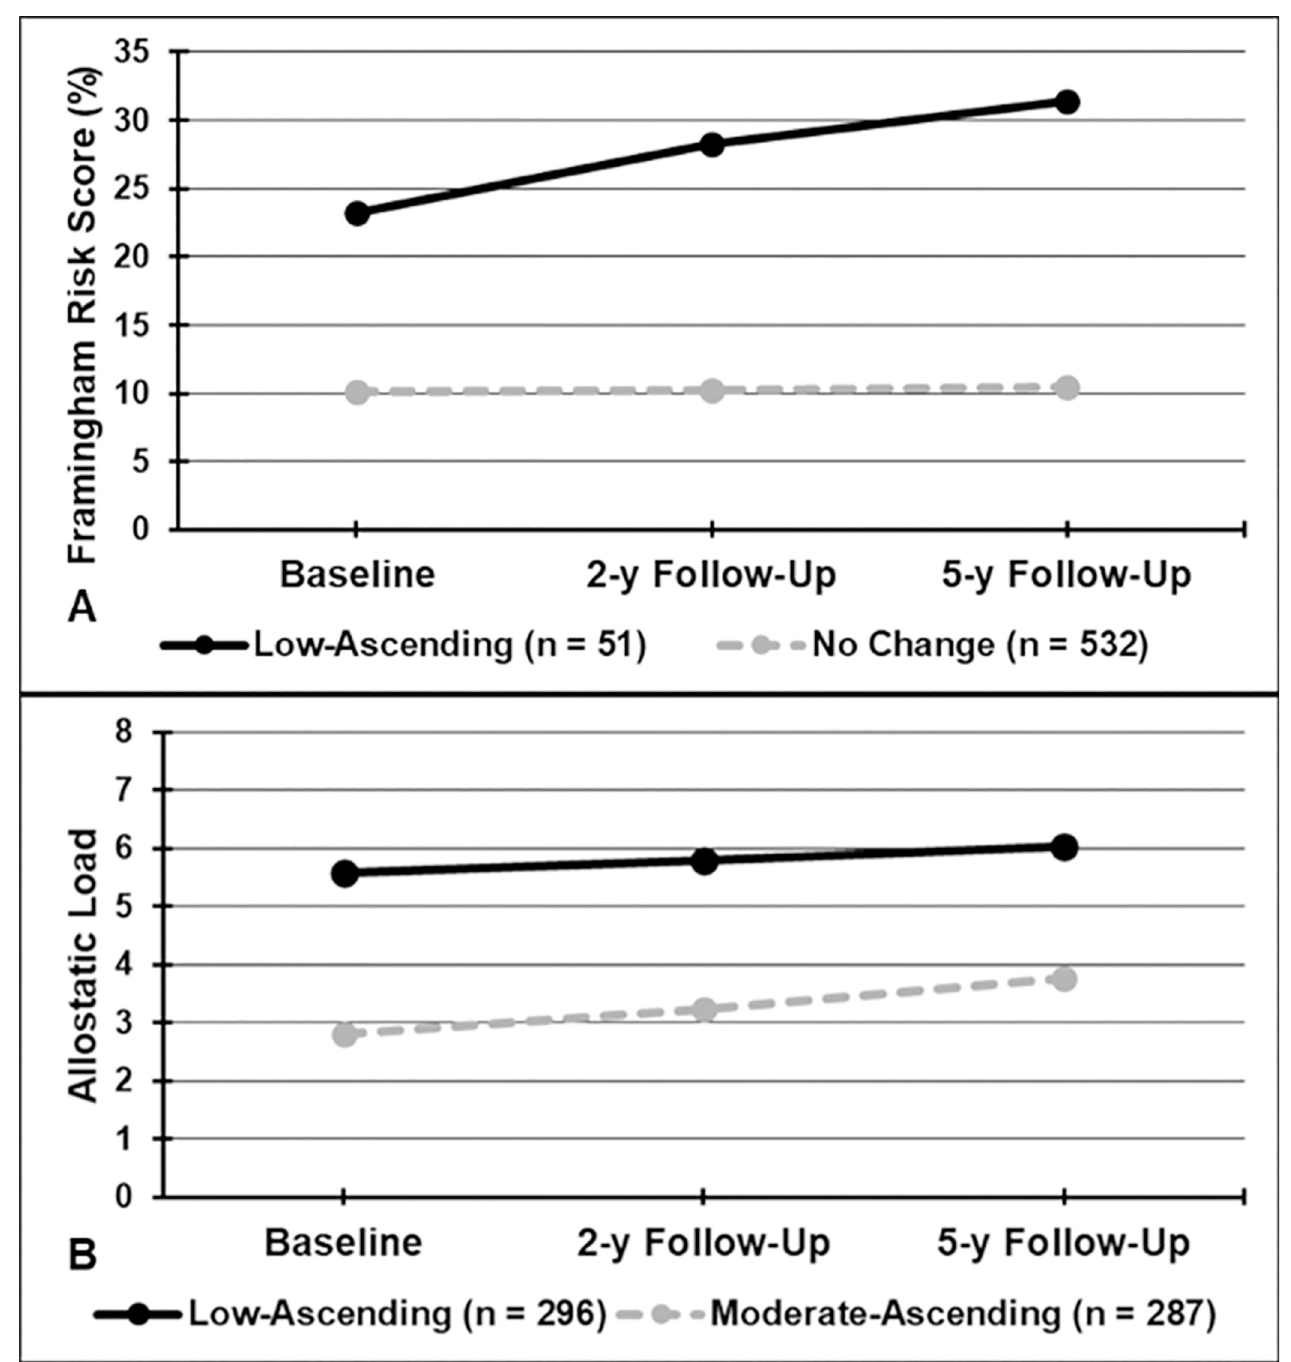
Fig 2. Predicted Trajectories for: A) Framingham Risk Scores; and B) Allostatic Load.